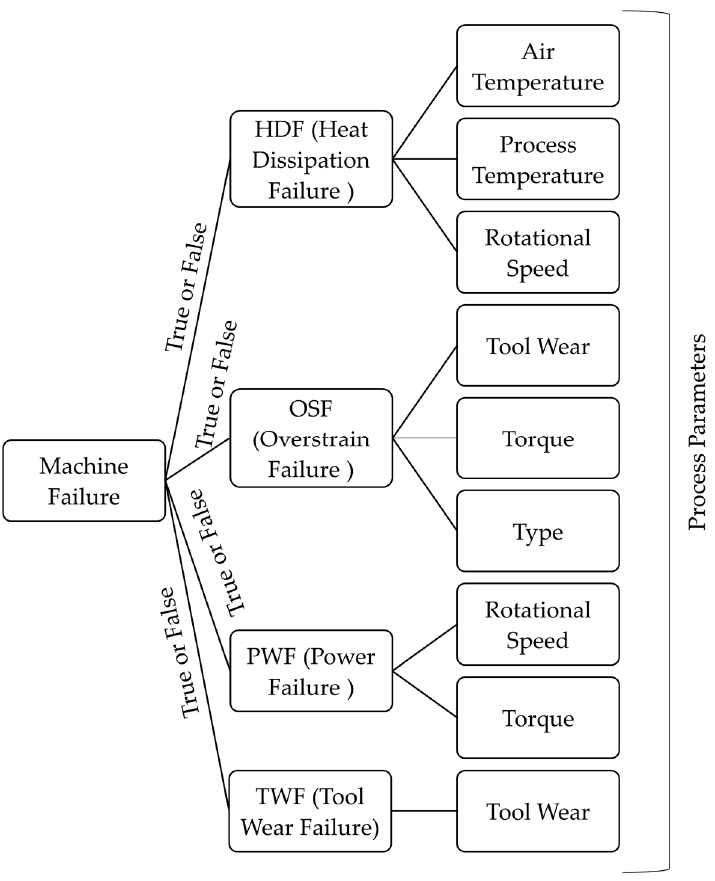
Figure 2. The explainable tree structure of the main modes of machine